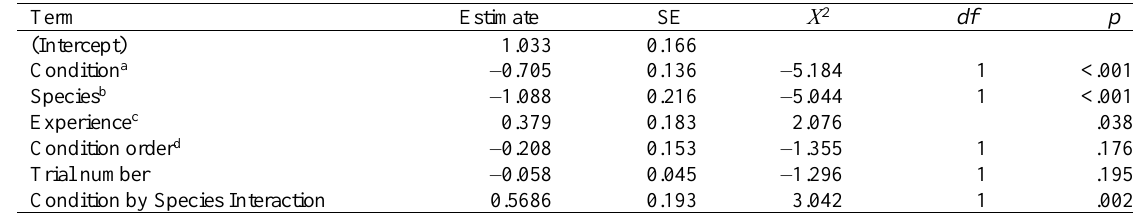
GLMM2: The Effect of an Interaction Between Species and Condition on Selecting the Correct Cup in Experiment 3 Term